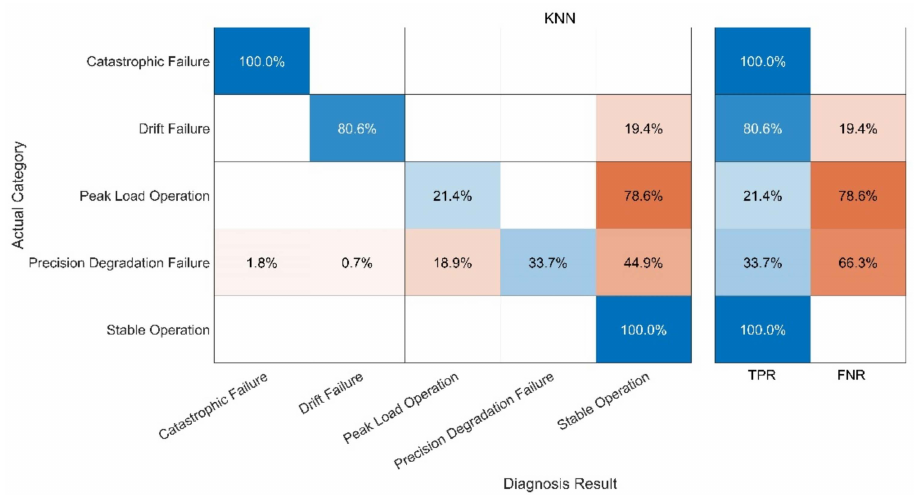
Figure 16. Fault Diagnosis Result of